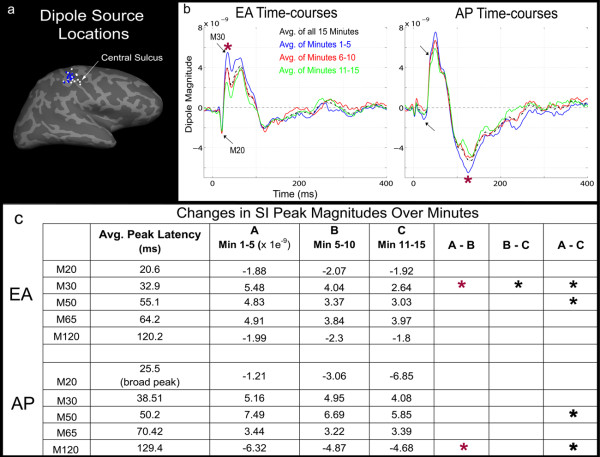
Evoked S1 responses to Electroacupuncture (EA) and Acupressure (AP): (a) For all subjects, the primary sources localized to the contralateral SI for EA (white dots) and AP (blue dots). Sources are shown as closest points on the cortex reconstructed from subjects' individual MRIs and morphed to an average inflated brain surface (sulci/gyri are dark/light gray respectively). (b) Average time-courses for all trials of EA and AP (black, dashed lines) demonstrated analogous M20, M30, M50/M60 and M120 (those of AP being slightly delayed). Five minute sub-averages (blue, red and green lines) show attenuation of peak-to-peak amplitude over the course of the run. (c) Peaks demonstrating significant decreases (p < 0.01) following 5 minutes of stimulation are marked by a red "*" For EA this was the M30 peaks and for AP the 130 ms peak. Significant differences occurring after > 10 minutes stimulation were seen for the M30 and M50 with EA and with the M50 and M120 with AP.